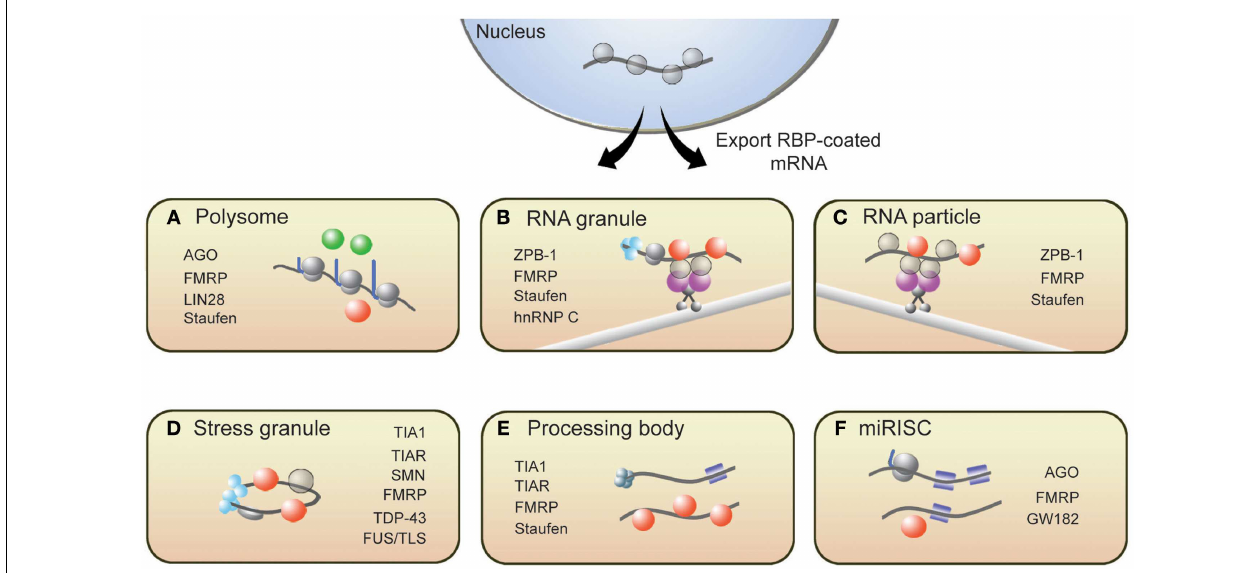
associated with translation initiation machinery (light blue spheres) including ribosomes, suggesting that translation has commenced but is halted during transit.The translational fate of mRNA is dictated in part by the RBPs bound to them. If targeted by repressor RBPs or miRISCs (blue squares), mRNAs will associate with (D) stress granules, (E) processing bodies, or (F) miRISC structures resulting in either degradation or translational repression. Some RBPs present in neuronal RNP complexes are